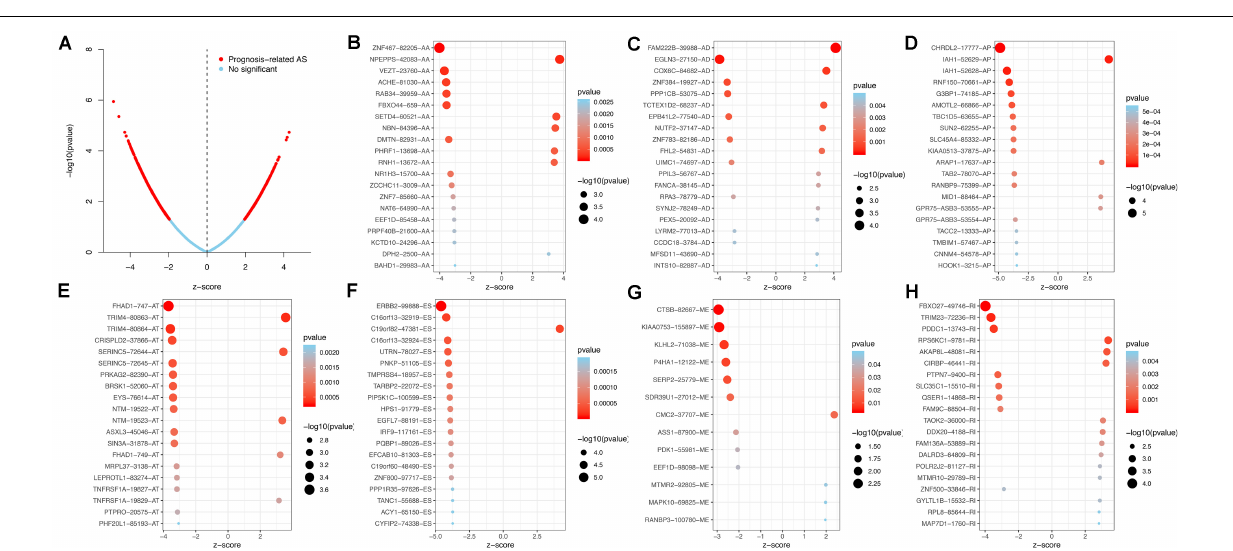
FIGURE 2 | Overview of seven types of AS in this study. (A) Number of AS events and related genes in ESCA. (B) UpSet plots in ESCA, showing the interactions among the seven types of OS-associated AS events. One gene may have up to seven types of AS events.